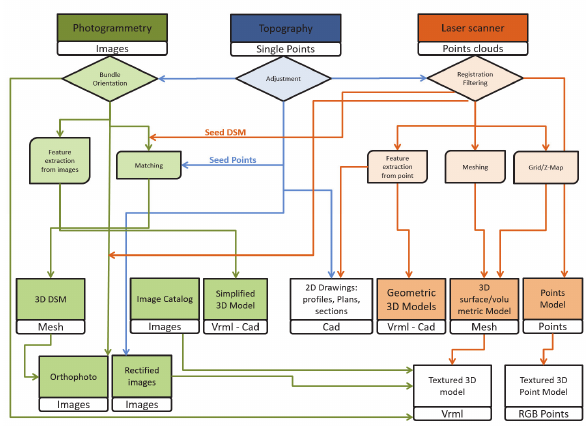
Figure 9: Integration of Photogrammetry, Laser scanning and Topography for Cultural Heritage Complex environment